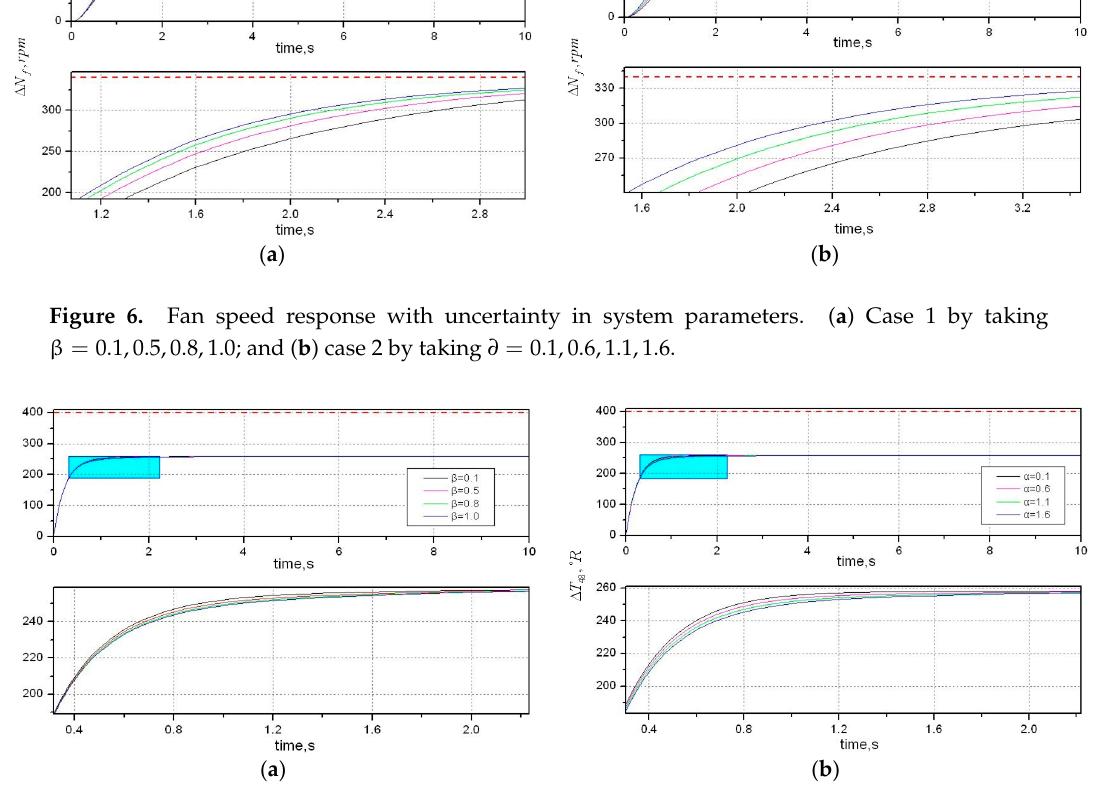
Figure 7. High-pressure turbine outlet temperature response with uncertainty in system parameters. ( a ) Case 1; and ( b ) case 2. Energies 2017 , 10 , 73